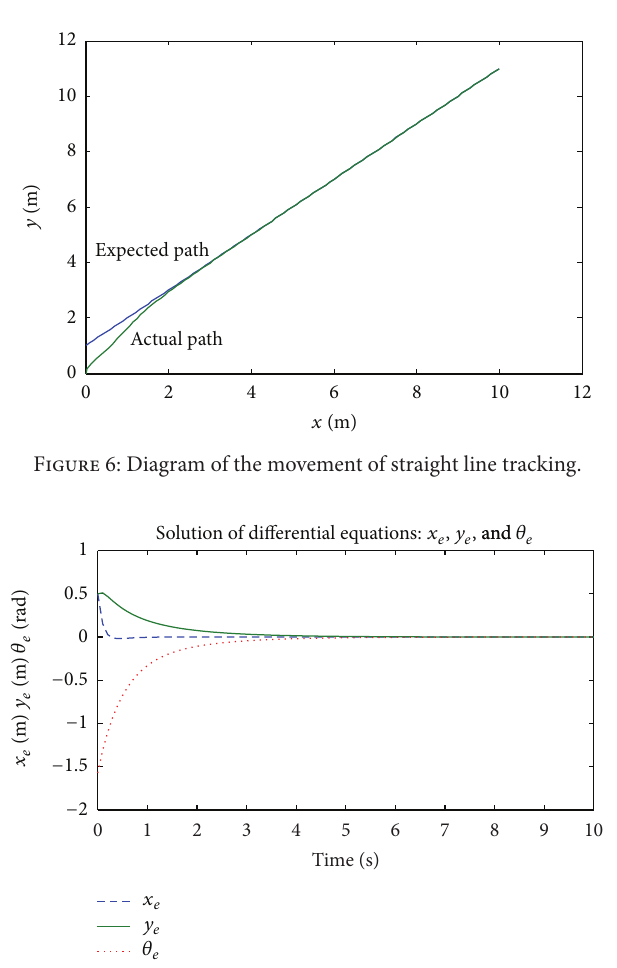
Figure 7: Diagram of error curve of circular tracking.